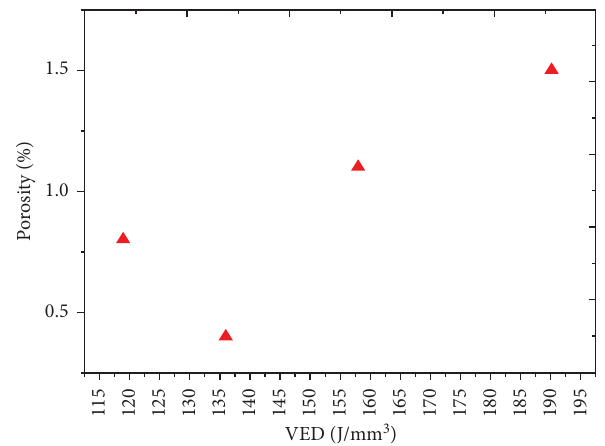
Figure 8: Porosity for product with volumetric energy density.